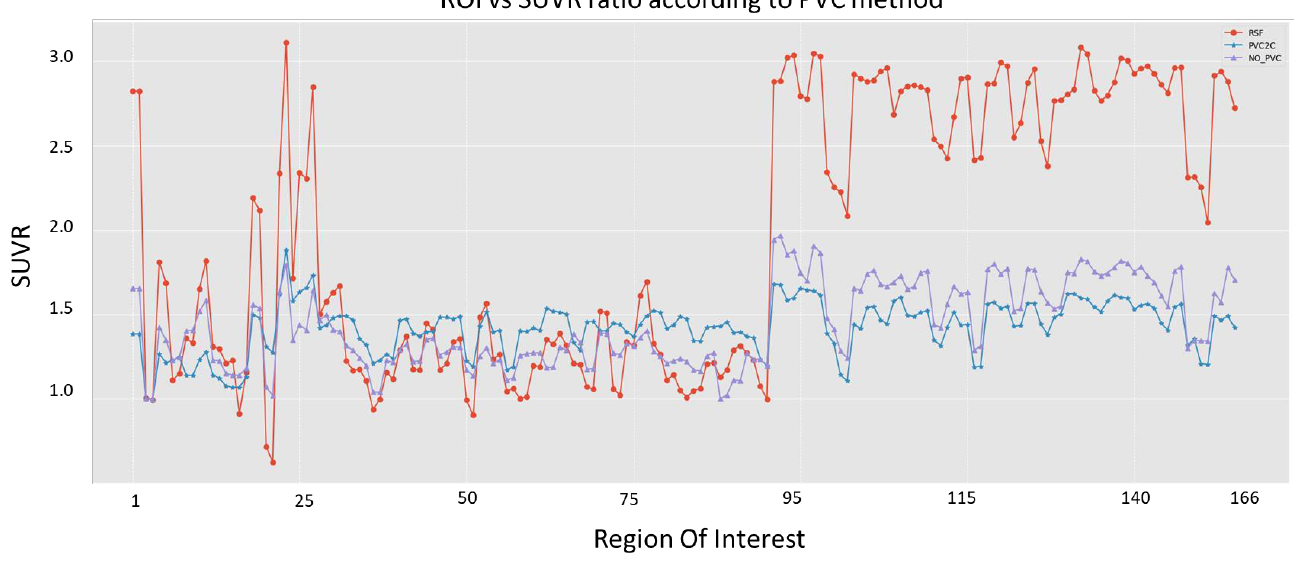
Figure 8. Plot of the mean SUVR values of the 166 anatomical regions obtained using the Desikan–Killiany atlas from the MRI study and after the application of the three PVCs to the original PET studio of 532 patients. In red, Regional Spread Function (RSF); in blue, PVC2C; and magenta, noPVC.